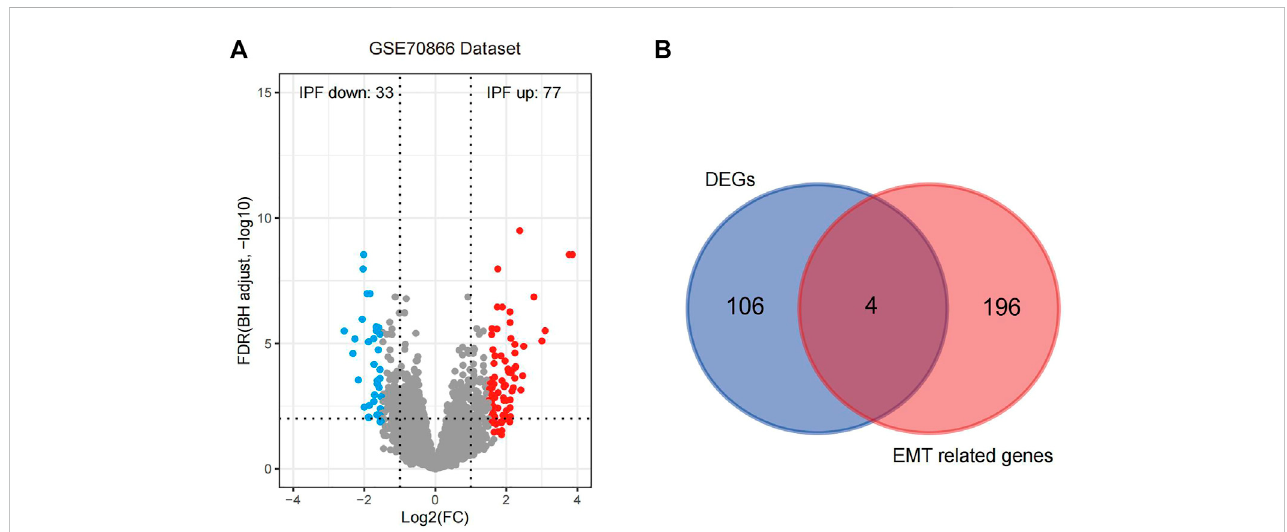
FIGURE 2 Acquisition and analysis offour EMT-related DEGs inIPF. (A) The110DEGs identi fi edaredisplayedinthevolcano plotbased onthecriteriaof p < .05and log 2 FC > 1.5. (B) The EMT-related genes are presented in a Venn diagram. IPF, idiopathic pulmonary fi brosis; EMT, epithelial – mesenchymal transition; DEGs, differentially expressed